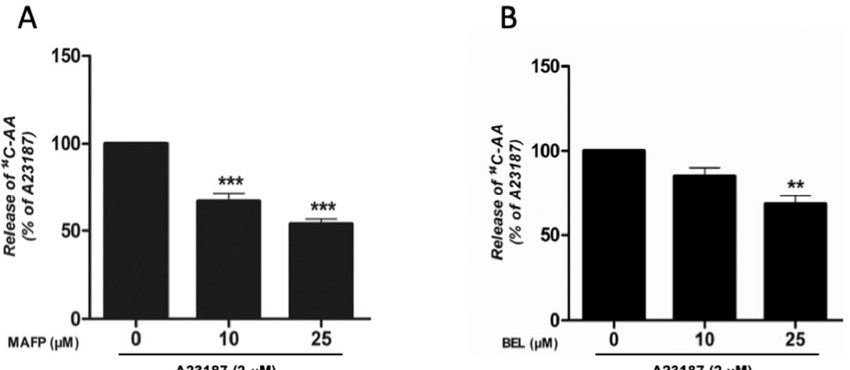
Figure 4. Effect of PLA 2 inhibitors on the calcium ionophore A23187-stimulated release of radiolabeled arachidonic acid (AA) from HMC-1. Cells were pre-treated for 30 min with various concentrations of PLA 2 inhibitors, prior to incubation with A23187 (2 µM) for an additional 4 h. (A) Effect of the combined cPLA 2 and iPLA 2 inhibitor methyl arachidonyl fluoro-phosphonate (MAFP). (B) Effect of the specific iPLA 2 inhibitor bromoenol lactone (BEL). * p < 0.05, ** p < 0.01, *** p < 0.001 vs. A23187-stimulated cells. Data from three independent experiments.